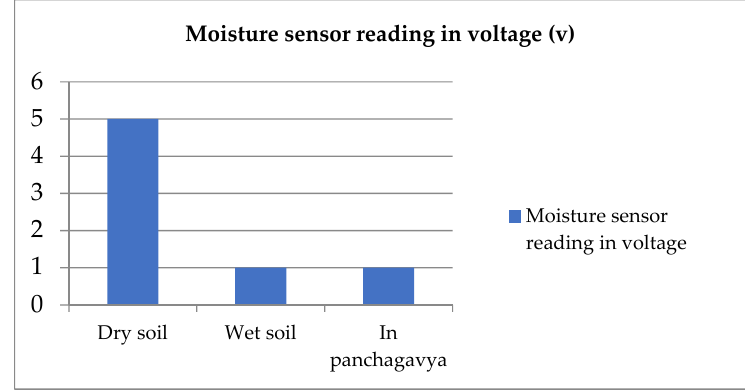
Figure 6. Moisture sensor reading in voltage.